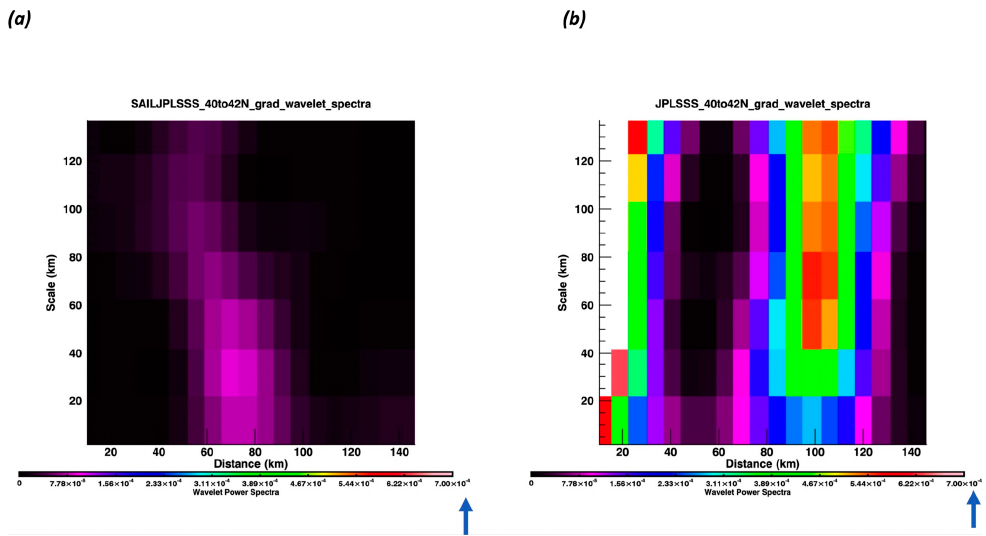
Figure 10. ( a , b ). Wavelet spectra from 40°N to 42°N for ( a ) SAILSSS and ( b ) JPLSSS. Arrows indicate the color associated with the 95% level of confidence.